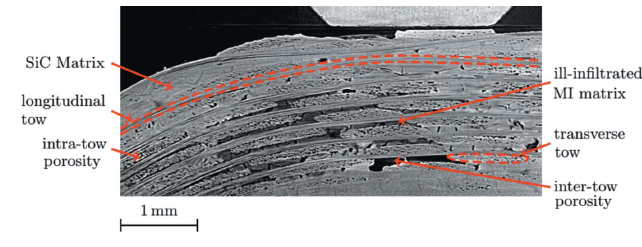
Figure 9 Tomographic reconstruction of the initial step after all artefact corrections.